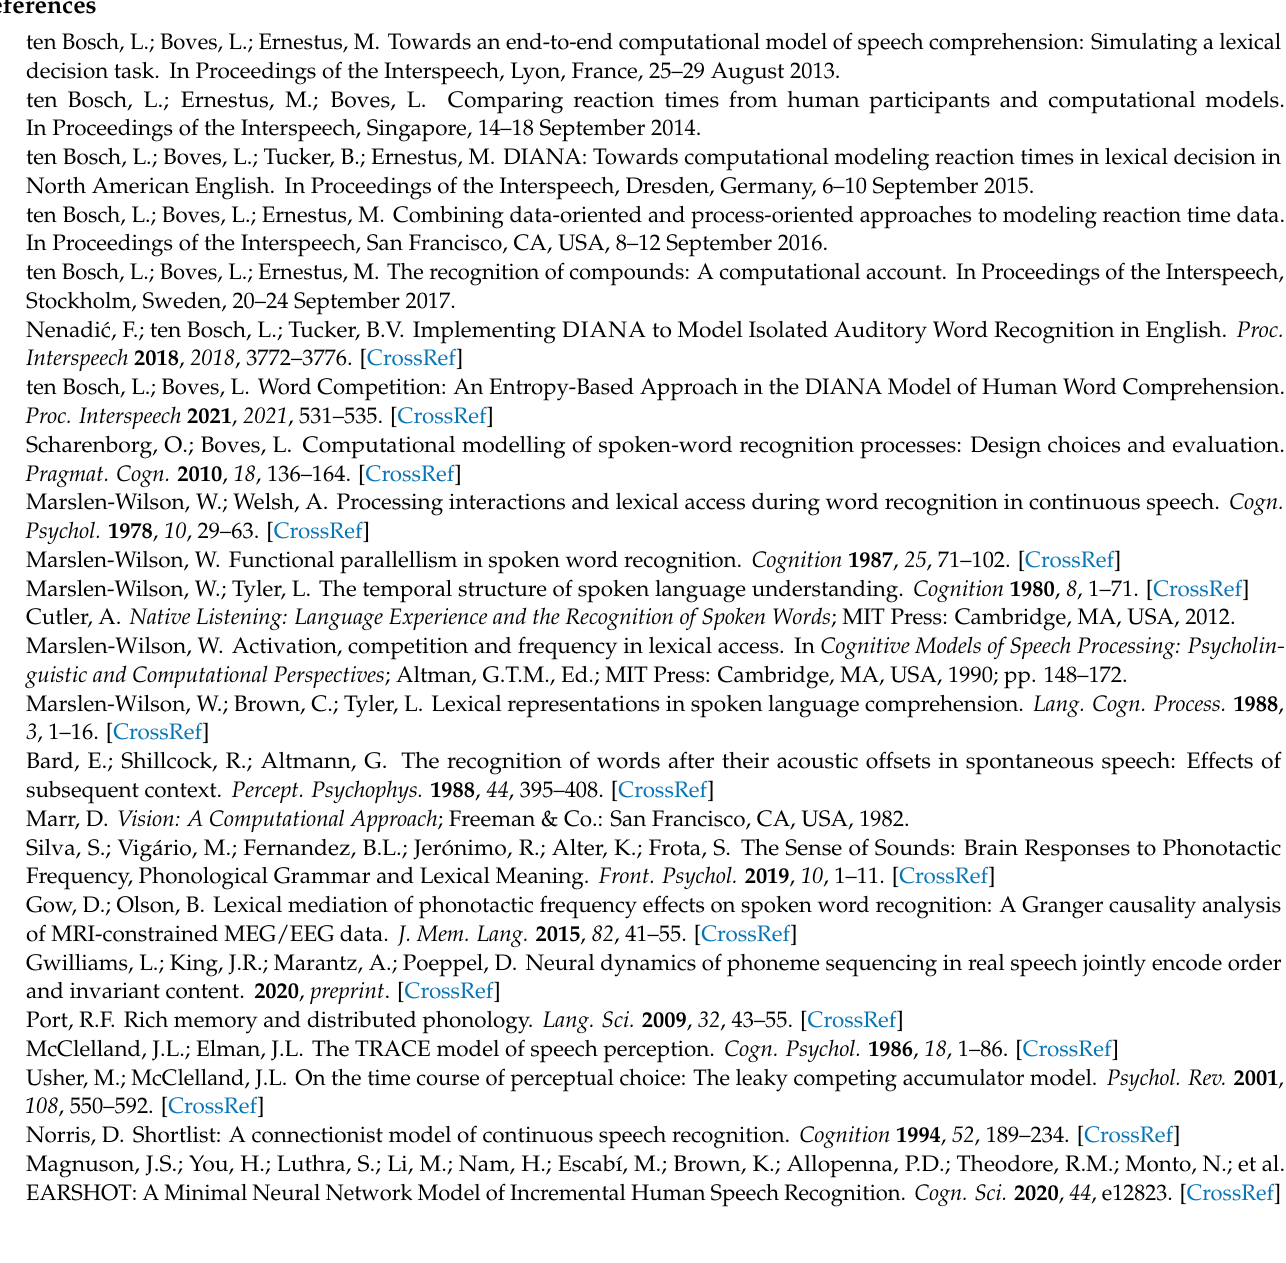
The figure shows the performance of DIANA via Equation (A9) in terms of the correlation between DIANA’s RT sequences and the average RTs from participants in BALDEY (the dotted black line) and the average RT (solid blue line), both as a function of the coefficient β in Equation (A9). The black dotted line shows that the highest correlation between DIANA and the participants is obtained for a value of β > 0 ( ρ max = 0.651, 95% confidence interval [0.641–0.663]), i.e., significantly higher than the prediction without entropy ( β = 0). The dashed blue horizontal line indicates the participant’s mean RT. The right-hand side vertical axis pertains to the blue curves. The figure suggests that there is no single value for β for which both the correlation is optimal (highest point in black curve) and the average RT prediction is correct (crossing of solid and dashed blue lines). This strongly indicates that the operational definition of entropy, as currently used, can be refined, by, e.g., taking into account more complex (morphologically oriented) word–word relation during DIANA’s word competition stage, in line with the discussion of Equations (A9) and